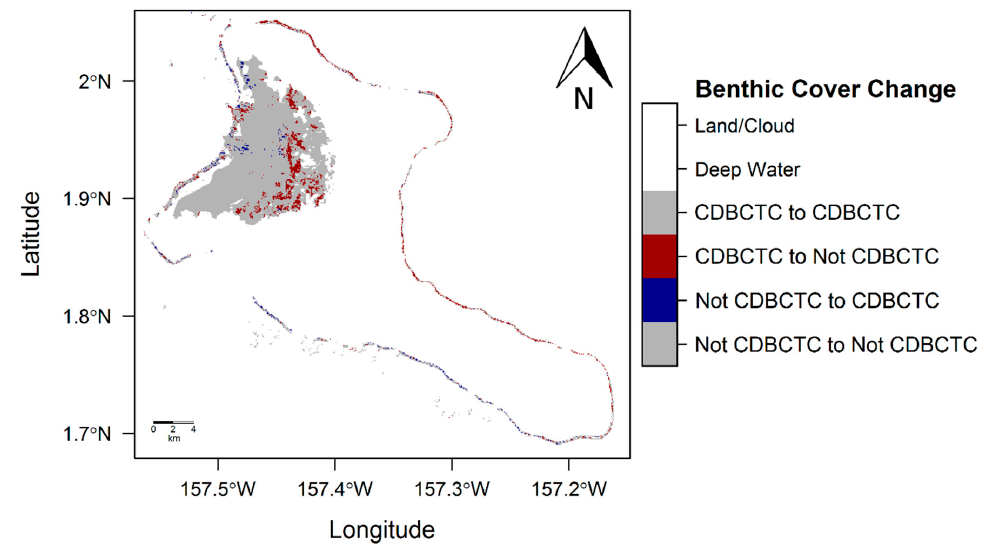
Figure 16. Difference in predicted class membership map for the Kiritimati Island area of interest for 2002 initial state compared to 2014 final state.